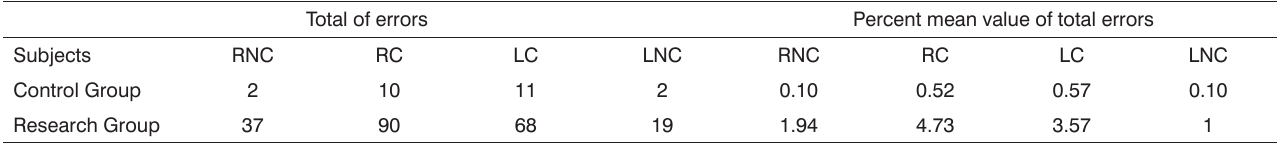
Chart 6. Comparison between total number of errors and percent mean values for control and research groups in non-competitive (RNC and LNC) and competitive (RC and LC) conditions.